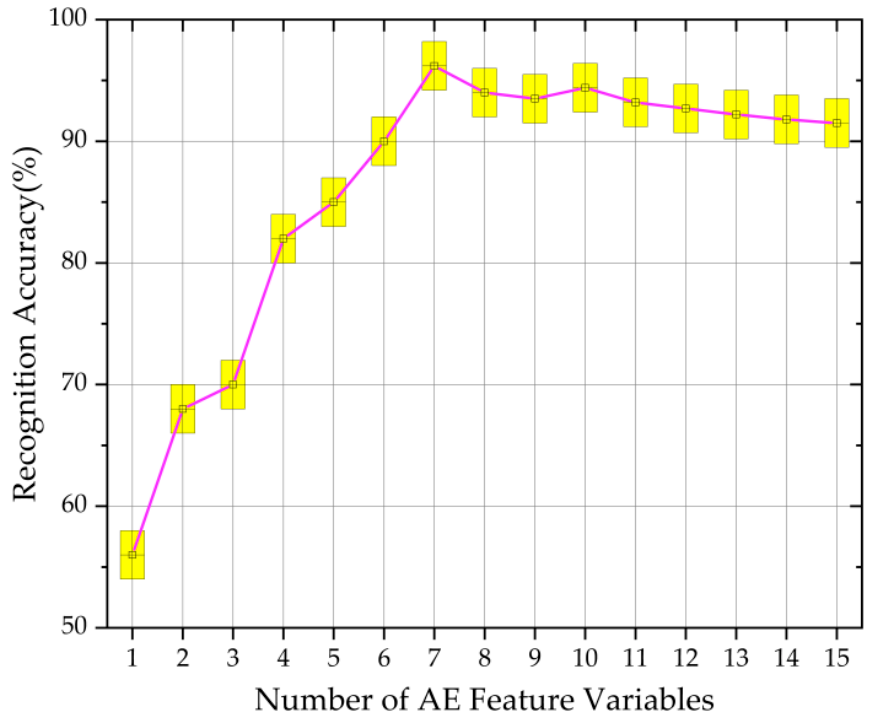
Figure 18. Box plot of recognition accuracy for different number of feature variables.